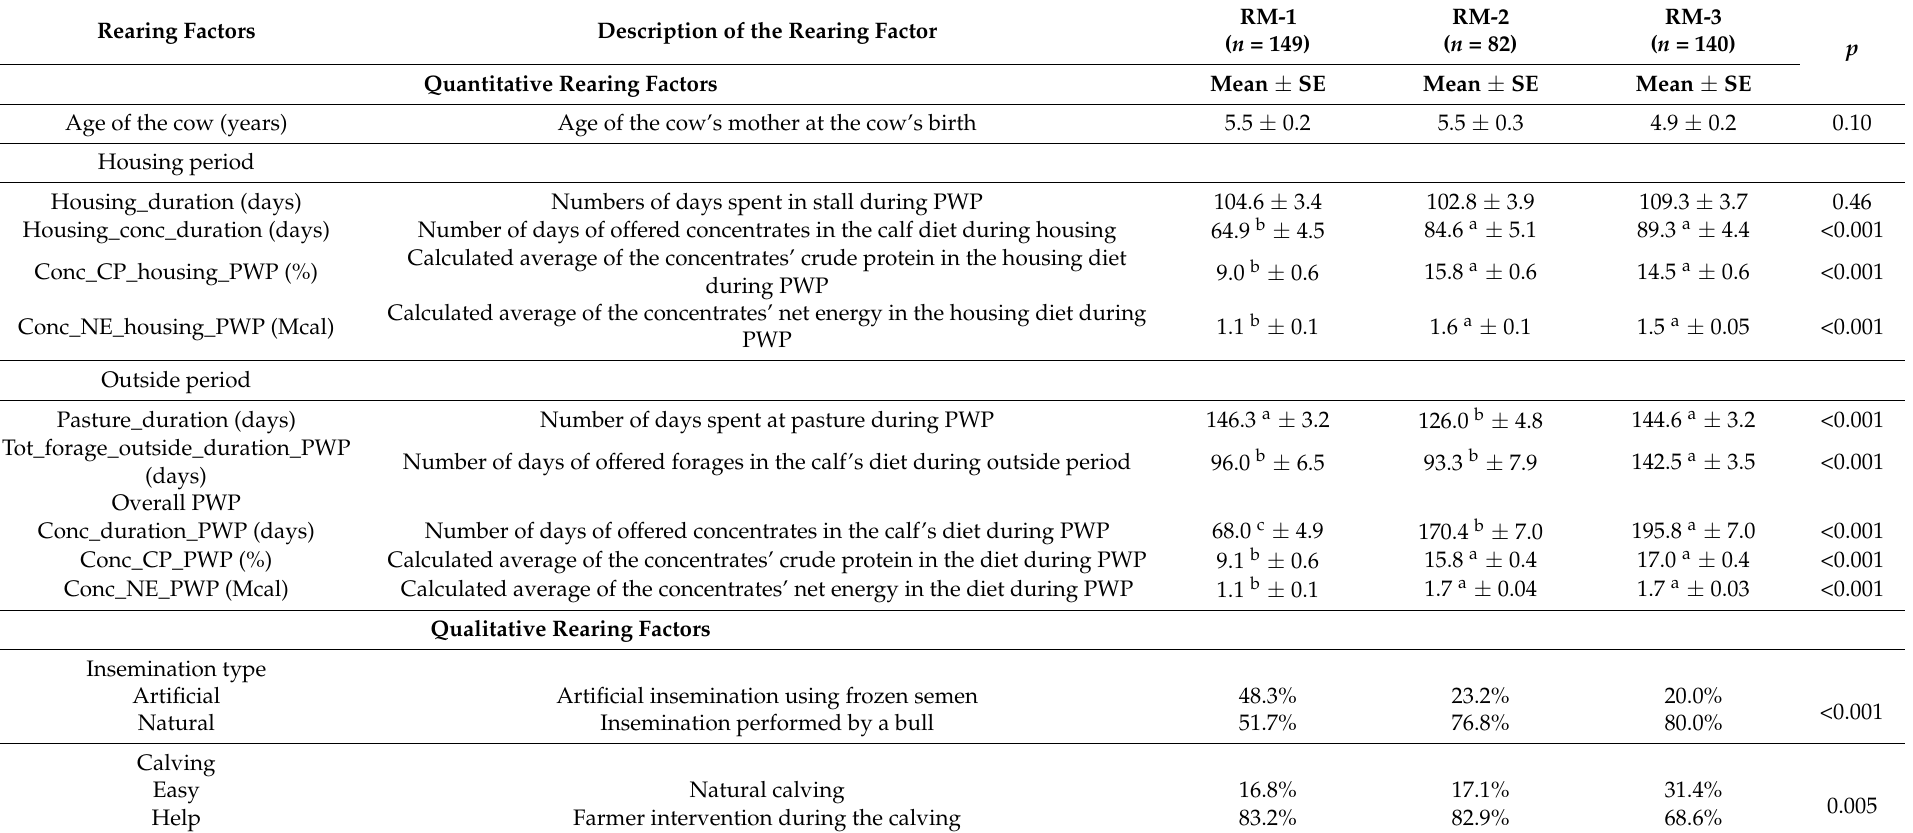
Table 3. Rearing factors characterizing the pre-weaning period (PWP) of the rearing managements (RM) applied during the cull cows’ whole